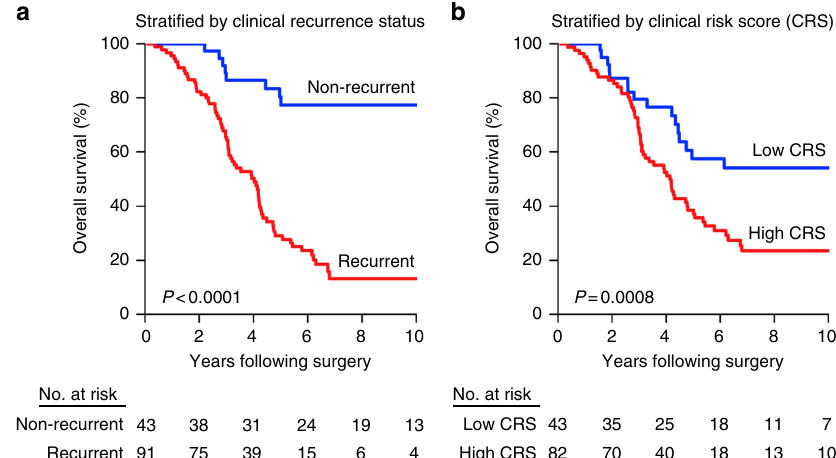
Fig. 1 Clinical outcomes following surgical resection of limited liver metastases from colorectal cancer. Kaplan – Meier curves of overall survival by a clinical recurrence status (as determined by post-operative surveillance CT imaging and serum CEA measurements) or b clinical risk scores (CRS) following hepatic resection of limited de novo CRCLM. Low CRS was de fi ned as values less than two. P -values were determined using log-rank